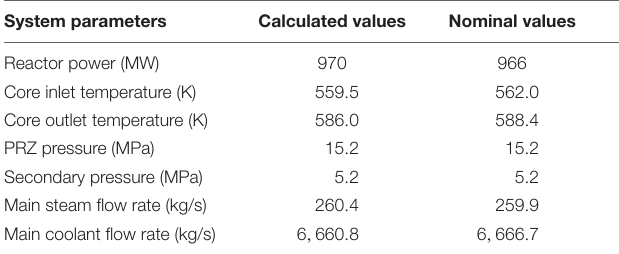
TABLE 1 | Comparison of calculated and nominal values of the key parameters during the nuclear power plant (NPP) operation.